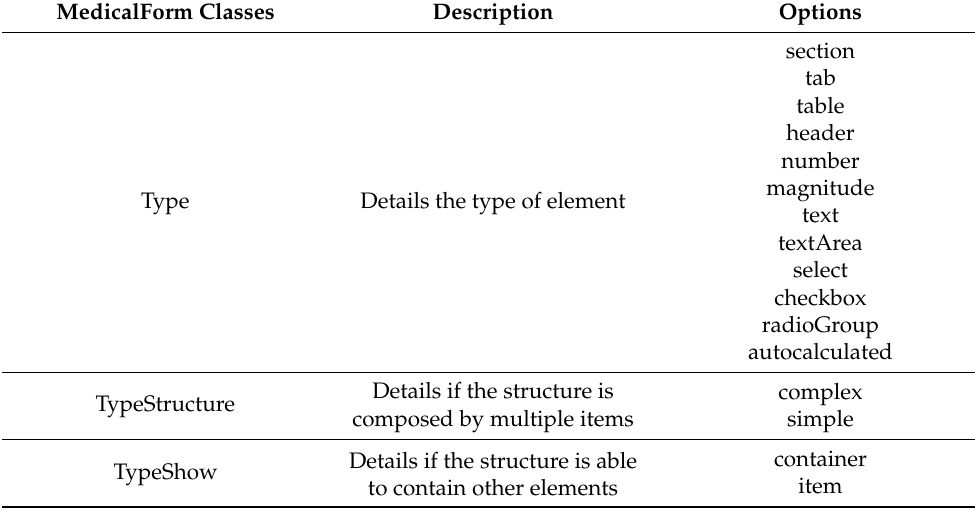
Table 1. Description of the most relevant classes of the MedicalForms JSON information